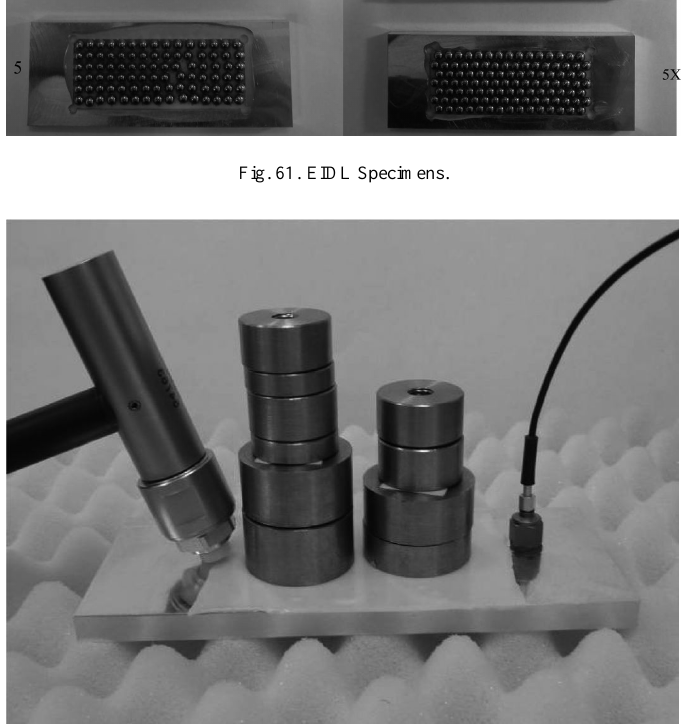
Fig. 62. Aluminium plate with EIDL loaded with 710 gr mass.